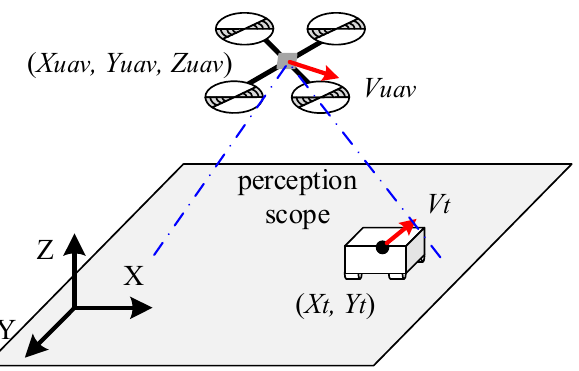
Figure 1. The schematic diagram of the unmanned aerial vehicle (UAV) tracking target problem. The movement of the UAV can be described by its location and velocity, noted as (cid:4671) , and the velocity vector is decomposed as 𝑉 𝑆 = (cid:4670)𝑋 , 𝑌 , 𝑍 , 𝑉 (cid:3048)(cid:3028)(cid:3049) (cid:3048)(cid:3028)(cid:3049) (cid:3048)(cid:3028)(cid:3049) (cid:3048)(cid:3028)(cid:3049) (cid:3048)(cid:3028)(cid:3049) (cid:3427)𝑣 , 𝑦 , 𝑧 (cid:3431) . Since the UAV always keeps at a constant altitude in this tracking system, (cid:3048)(cid:3051) (cid:3048)(cid:3052) (cid:3048)(cid:3053) the vertical velocity of the UAV 𝑧 (cid:3048)(cid:3053) = 0 . The motion equations of UAV can be expressed as Equation (1).